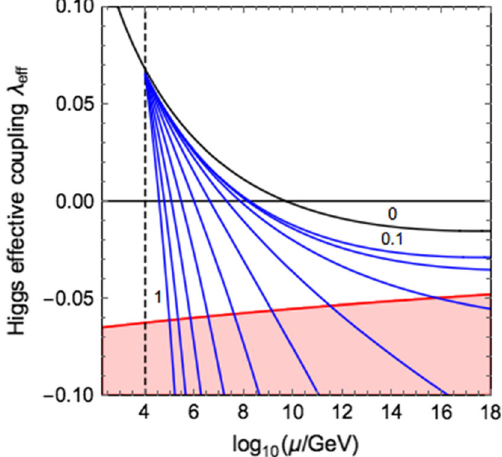
Fig. 9 Running of λ eff in the presence of a common heavy neutrino threshold M R = 10 TeV. Labels denote the value of y ν ∈ [ 0 . 1 , 1 ] with steps of 0 . 1 (blue curves), while y ν = 0 corresponds to the SM case (black curve). The instability bound is represented by the red-shaded